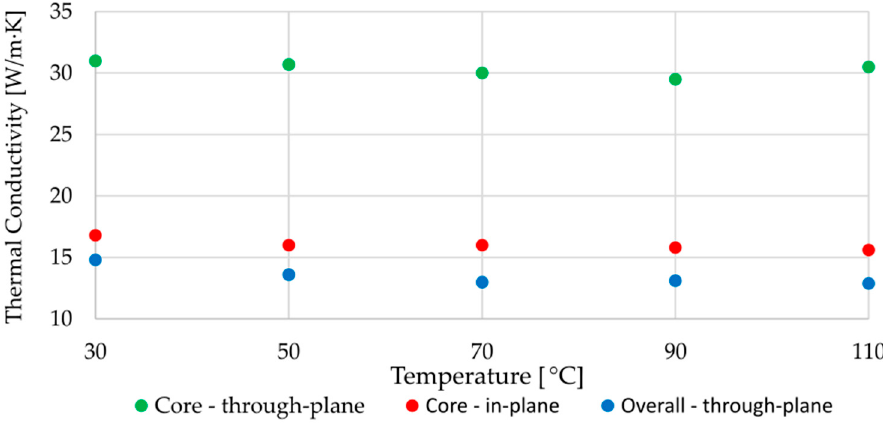
Figure 5. Measured thermal conductivities in the study by Grundler et al. [29].